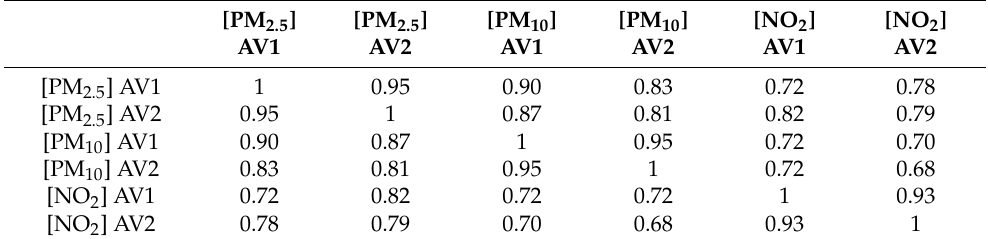
Figure 3. Daily average concentrations of PM 2.5 during September 2021 at AV1 and AV2 monitoring stations. Table 2. Pearson correlations of NO 2 , PM 2.5 , PM 10 , for AV1 and AV2 monitoring stations during September 2021 ( p <